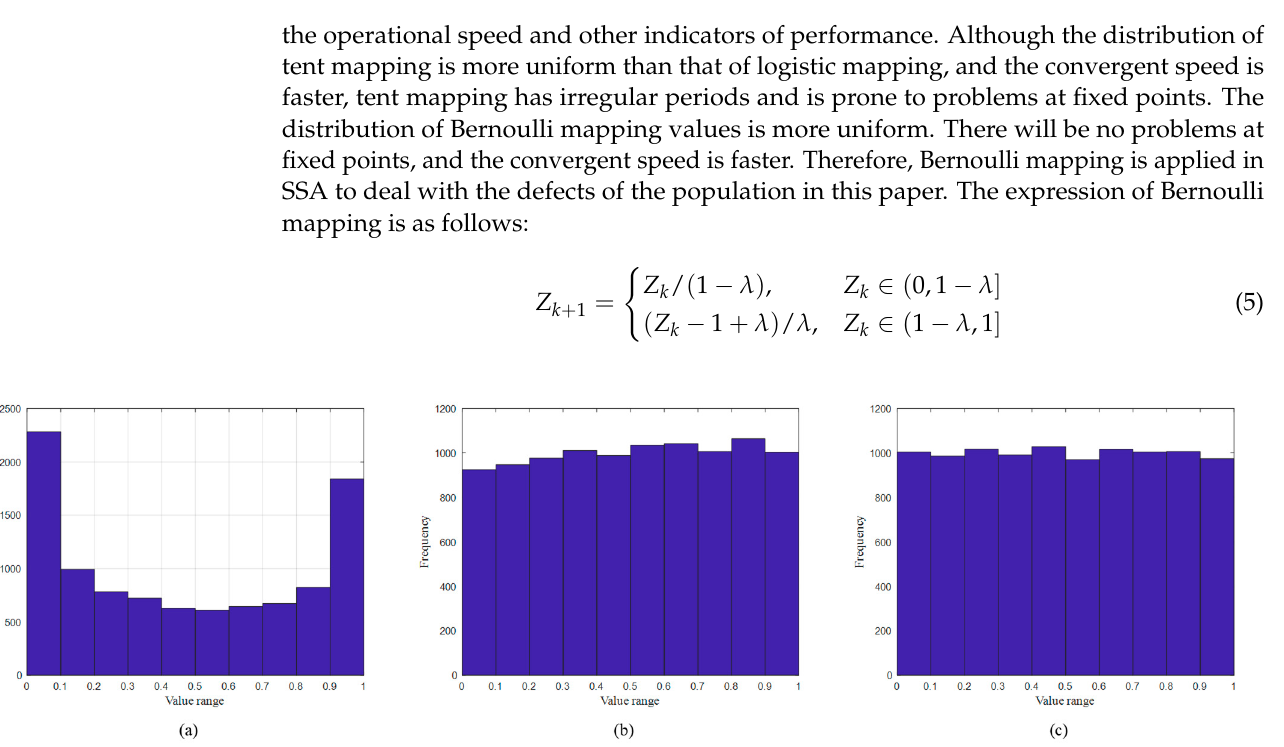
Figure 1. Distribution histogram of three chaotic mappings: ( a ) distribution histogram of Logistic mapping; ( b ) distribution histogram of Tent mapping; ( c ) distribution histogram of Bernoulli mapping.